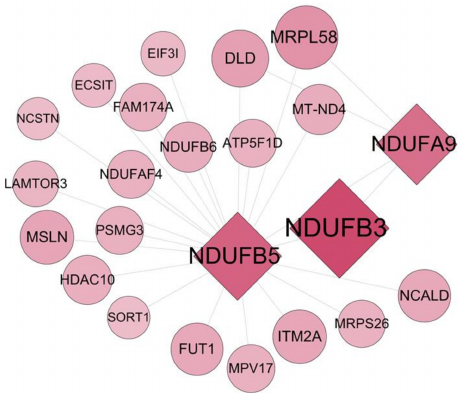
Figure 7. Hub genes (in squares) that showed the strongest relationship with mitochondrial metabolism, and other genes that interact with the hub genes (in